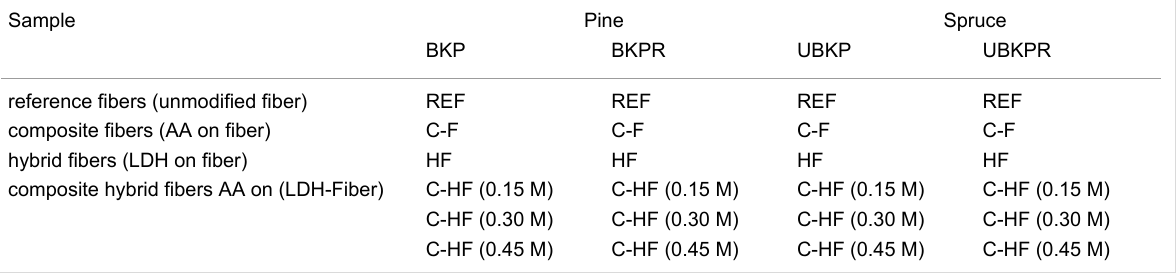
Table 2: Samples studied in the present investigation. Note: Bleaching of the fibers was not done at the laboratory. They were obtained as such com- mercially. Whereas refining was done at the laboratory.